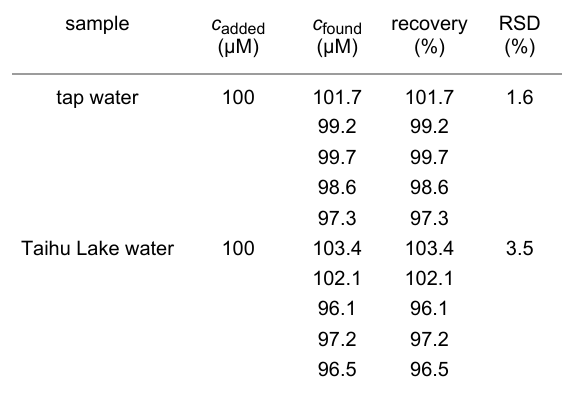
Table 2: Recovery experiment of detection of catechol in real water